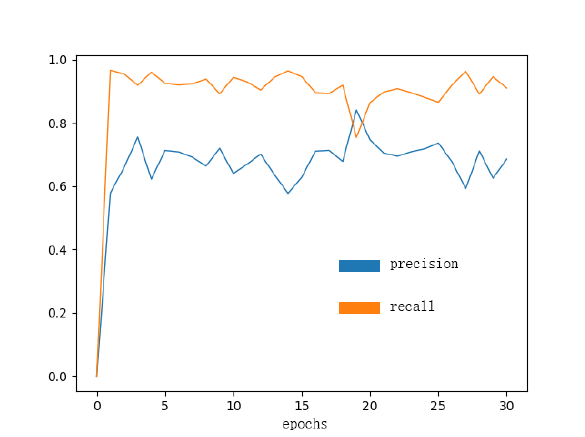
Figure 6. Precision and recall in training epochs.